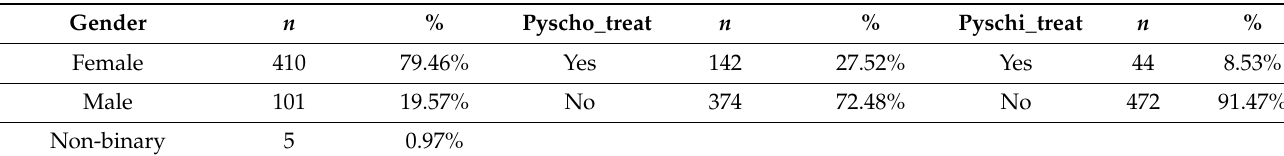
Table 1. Sociodemographic descriptors.